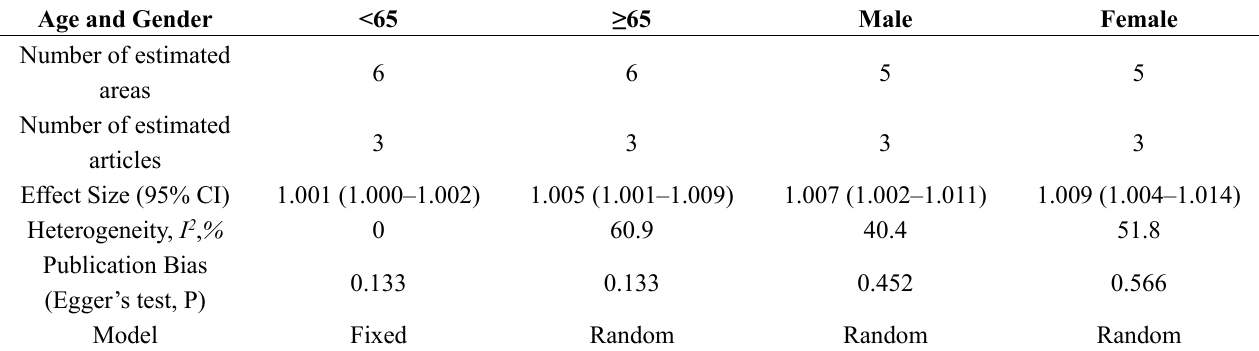
Table 4. Sensitivity Analyses for Cold Effects: Age and Gender.